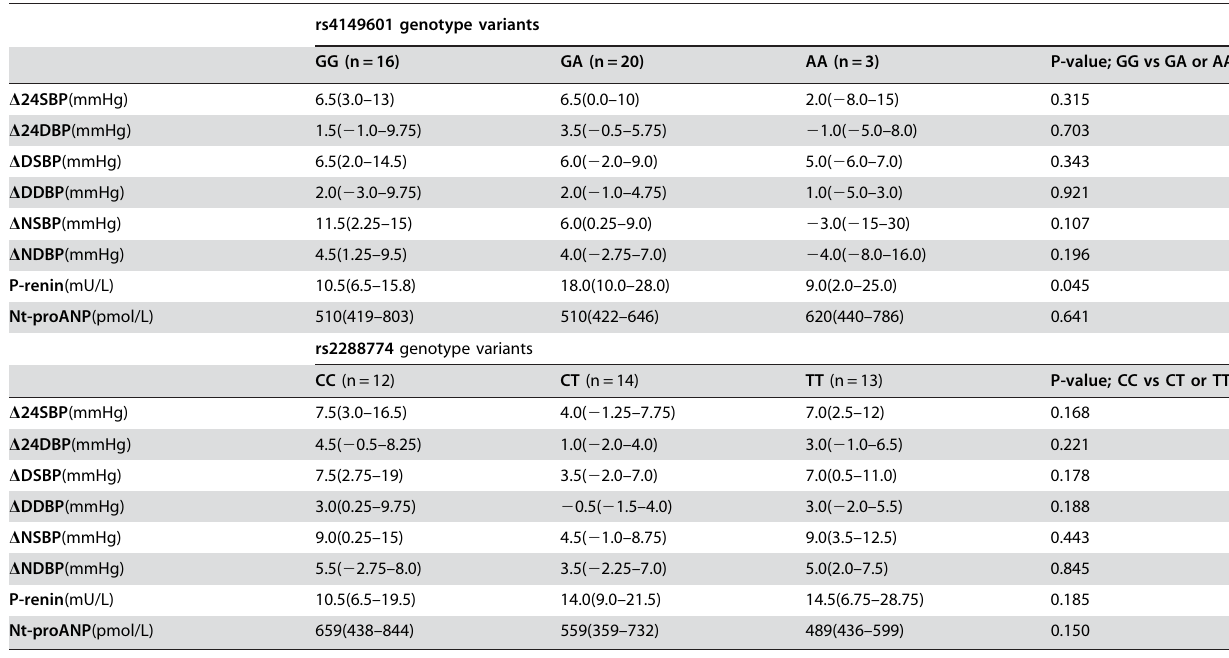
Table 2. Salt-induced changes in blood pressure and baseline P-renin and Nt-proANP in different genotype carriers. .. ... .... ... ... .... ... ... .... ... ... .... ... ... .... ... ... .... ... ... .... ... ... .... ... ... .... ... ... .... ... ... .... ... ... .... ... ... .... ... ... .... ... ... . rs4149601 genotype